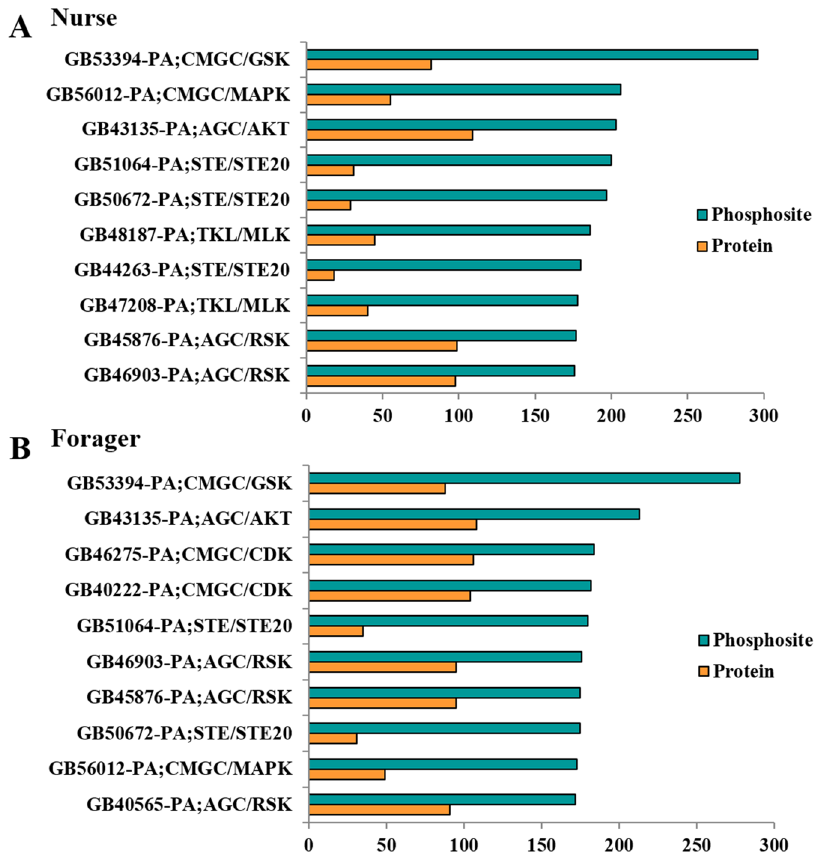
Figure 4. Group-based Prediction System (GPS) algorithm with the interaction filter, or in vivo GPS (iGPS). ( A ) The top 10 PKs with the most phosphosites by the prediction of iGPS in nurse bees. ( B ) The top 10 PKs with the most phosphosites by the prediction of iGPS in forager